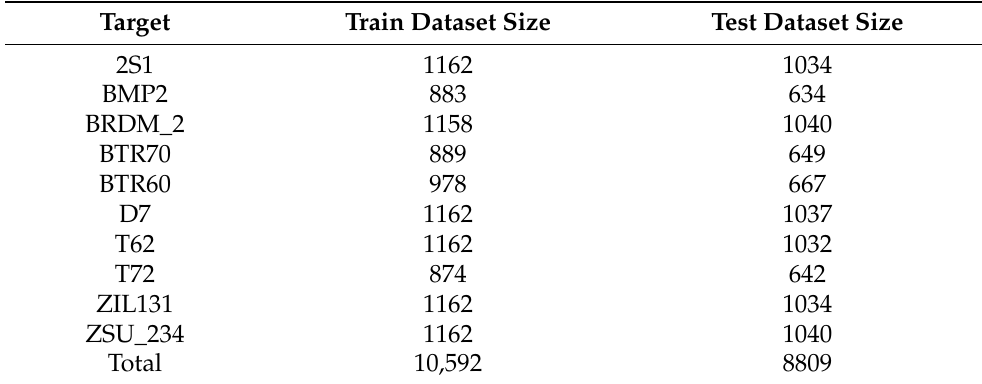
Table 2. The size of SOC dataset.